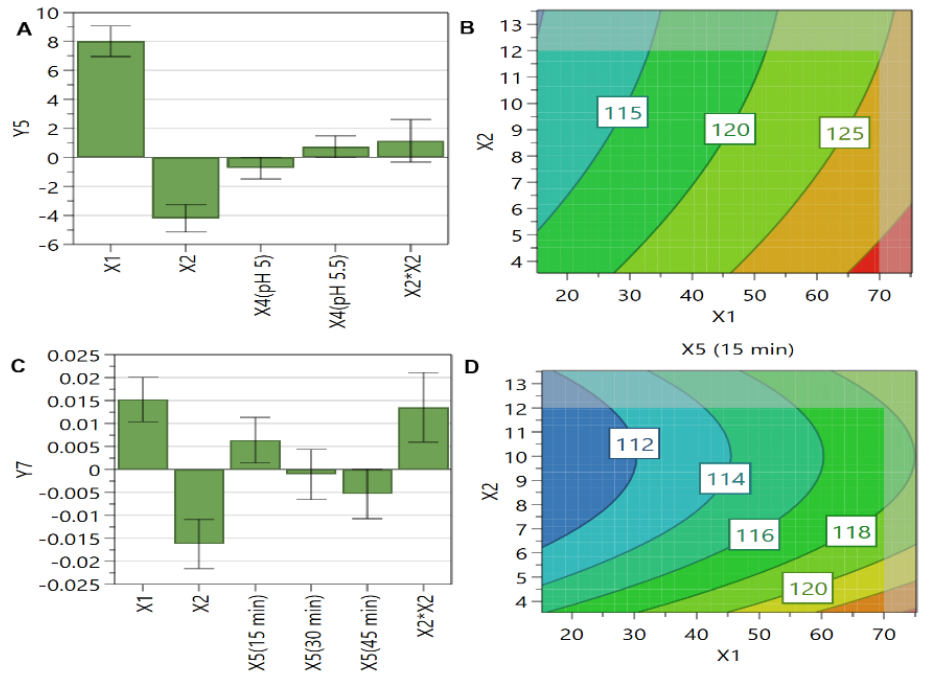
Figure 4. The coefficient plots for liposomal size before the incubation with DOX ( A ) and after the incubation with DOX ( C ) showing the significance of formulation factors in respect to these responses. The response contour plots for liposomal size before the incubation with DOX ( B ) and after the incubation with DOX ( D ) showing the variance of experimental results in respect to PL concentration (X1) and SIM concentration (X2). X1: PL concentration (mM); X2: SIM concentration (mM); X4: the pH of the AS solution; X5: incubation time with DOX (min); Y5: liposomal size before the incubation with DOX (nm); Y7: the liposomal size after the incubation with DOX